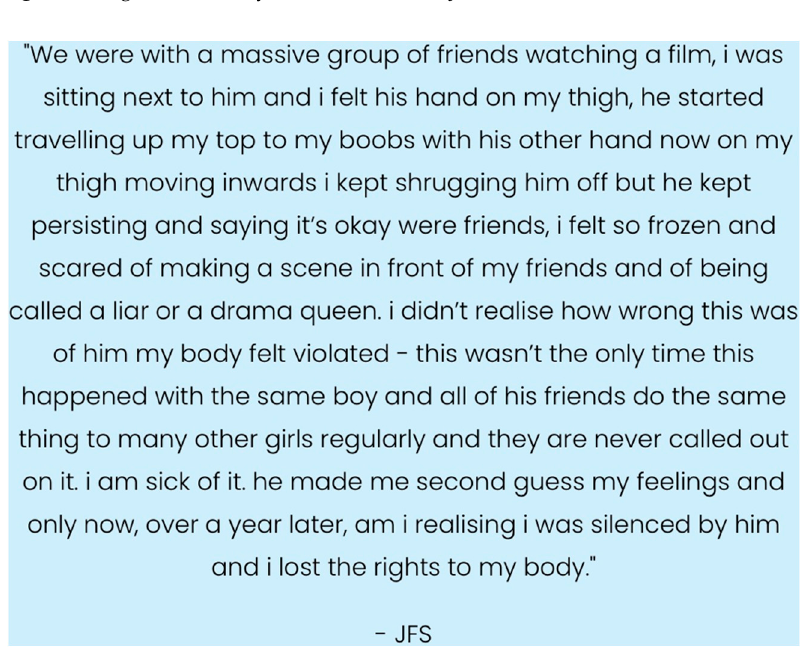
Figure 1. Digital testimony submitted to Everyone’s Invited .